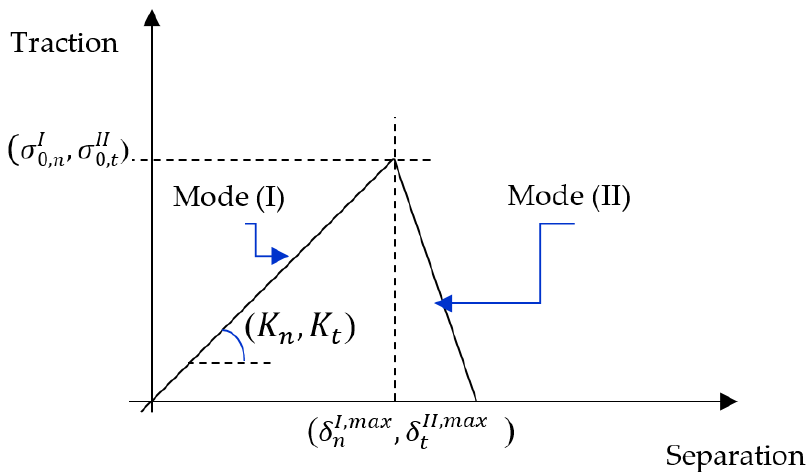
Figure 1. Stress-strain curves for steel [2].